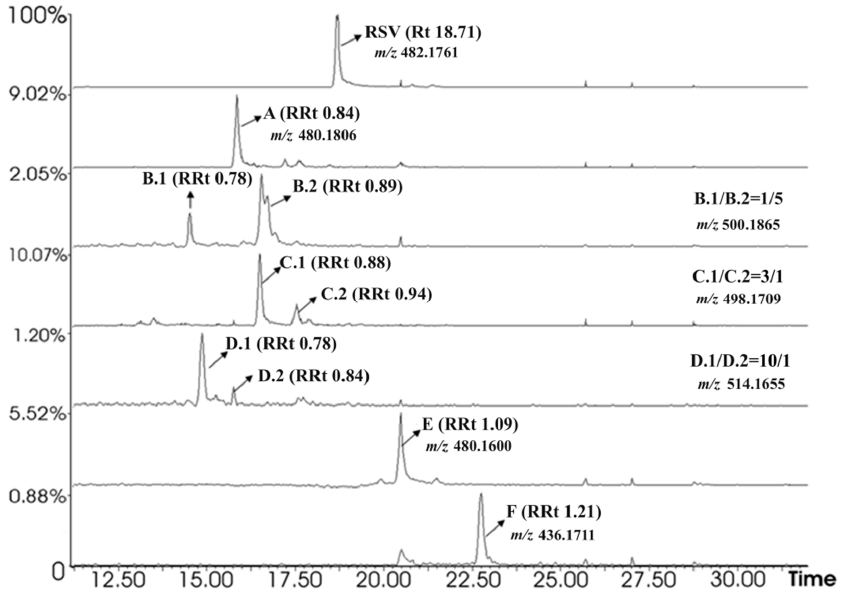
Figure 2. Extracted ion chromatograms of RSV (Rt 18.71) and gamma radiation-induced degradation products at 1000 Gy with observed relative retention time (RRt). Intensities of degradation products are normalized to the RSV principal peak. Peak areas of degradation peaks are expressed as percent area of the RSV principal peak. Fraction of extracted peak masses of B.1/B.2, C.1/C.2, and D.1/D.2 is calculated by dividing isobaric peak areas.